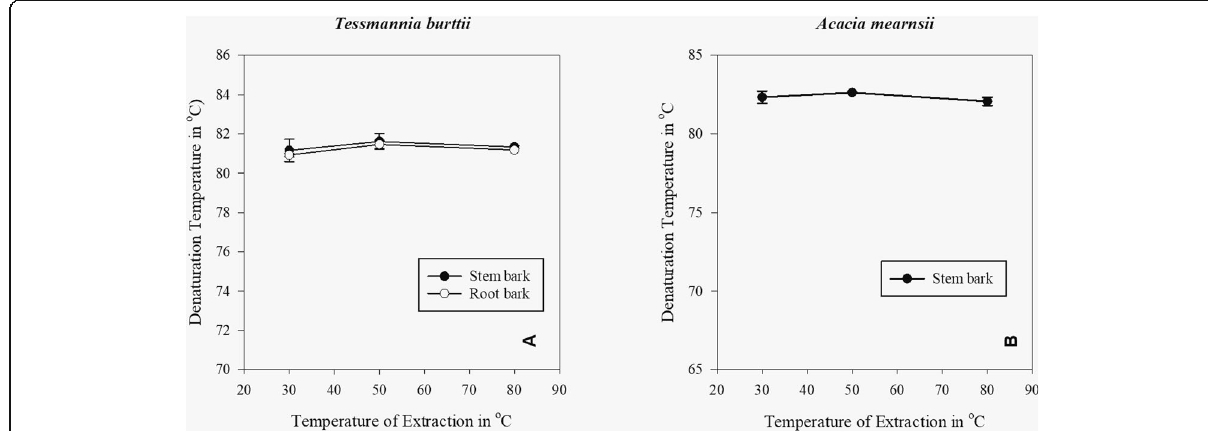
Fig. 1 Denaturation Temperature T onset of hide powder cross-linked with extract of Tessmannia burttii ( a ) and Acacia mearnsii ( b ) at pH 5 with dependence to temperature of extraction